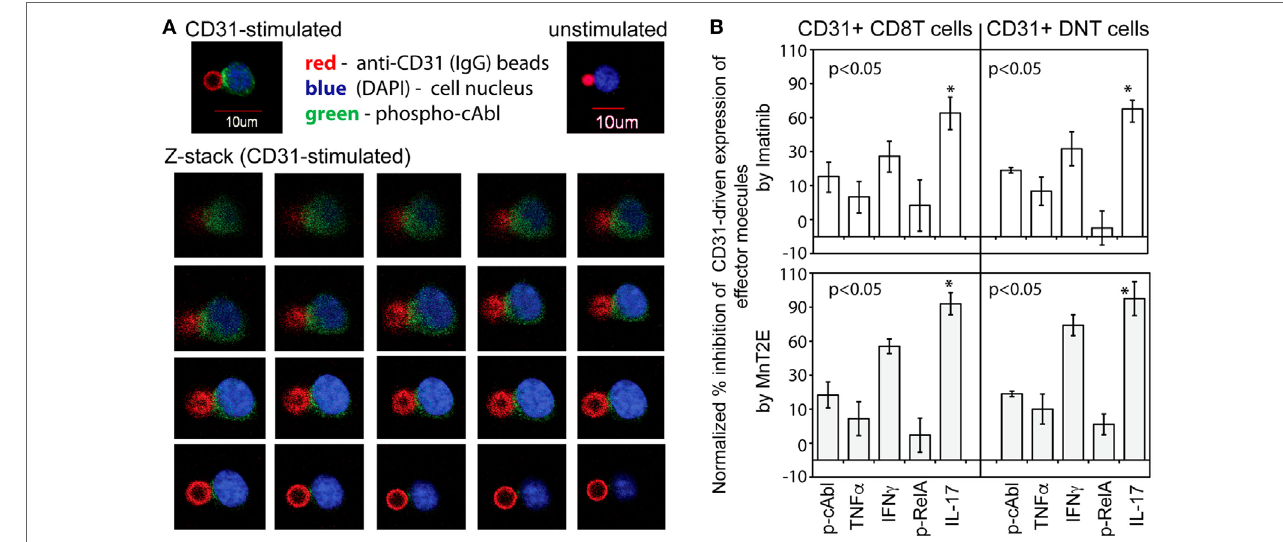
FigUre 5 | cAbl is a signaling substrate of CD31-driven TCR-independent activation of synovial αβ T cells. (a) Micrographs shown are representative confocal images of CD31-driven polarization of cAbl in αβ T cells from five independent experiments. The Z-stack (left to right order) were sequential image slices from the top to the bottom of a cell (DAPI and Green staining) and a fluorescent bead (Red) with immobilized anti-CD31. (B) The data shown (bar means, SD whiskers; n = 4–7 per group) are percent inhibition of CD31-driven expression of phospho-cAbl and phospho-RelA, and intracellular expression of TNF α , IFN γ , and IL-17A by 50 nM Imatinib or 34 µM MnT2E in CD31-crosslinked synovial CD31 + CD28 null DN and CD8 + αβ T cells CD31 crosslinking was performed as in Figure 3a . Data normalization was done as in Figures 3B and 4 . The indicated P -values were determined by Kruskal–Wallis ANOVA. Post hoc group comparisons by Tukey: * P < 0.05 indicates MnT2E and Imatinib induced greater magnitudes of reduction of CD31-driven IL-17A expression than the inhibitor-induced reductions of cAbl, TNF α , IFN γ , and RelA